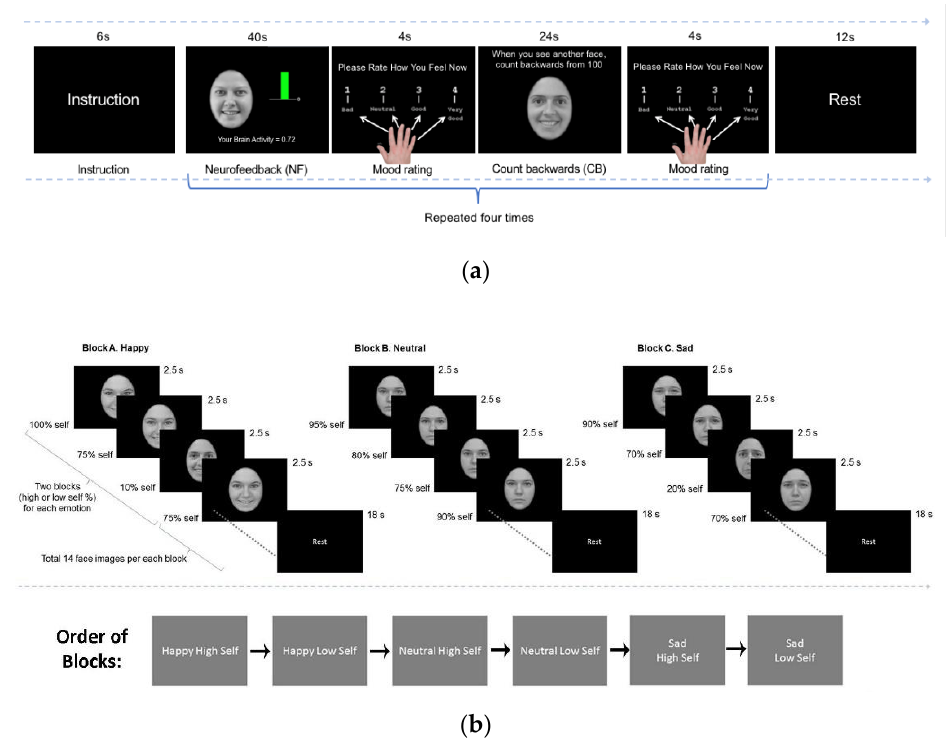
Figure 1 . Task Structures: ( a ) Emotional Self-Other Morph Neurofeedback Task (ESOM-NF) entailed participants recalling positive autobiographical memory to the cue of their own smiling face for 40 s and attempting to increase the green bar (the amygdala-hippocampal complex), viewing another’s face and counting backward for 24 s, rating their mood for 4 s after feedback or count backward blocks, and resting for 12 s. ( b ) Emotional Self-Other Morph-Query (ESOM-Q) was administered before (ESOM-Pre) and after (ESOM-Post) the neurofeedback task (ESOM_NF). Participants recognized faces as either their own or as different face via button press.